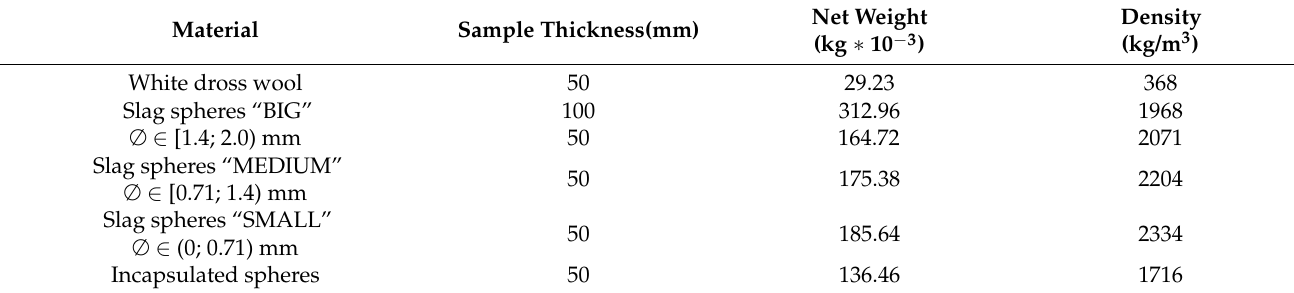
Figure 6. Sample of slag spheres encapsulated in inert material. Table 1. Characteristics of the analyzed specimen: sample thickness, net weight and